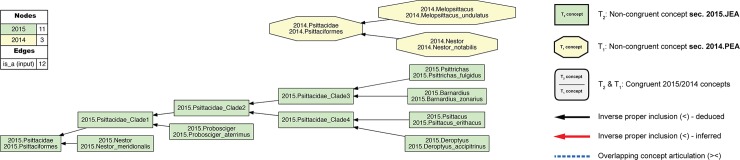
Alignment visualization for the 2015./2014.Psittaciformes alignment, with coverage globally applied.This alignment corresponds to the Fig 1 input, and shows reasoner-inferred non-/congruent concepts and articulations (see legend)–i.e., none in this particular case. The reasoner infers 108 logically implied articulations that constitute the set of MIR. See also S2 File. Although the input and alignment of Figs 1 and 2 are empirically defensible, they fail to capture certain intuitions we have regarding the higher-level 2015./2014.Psittaciformes relationship. For instance, we may wish to say: "Sure, the author teams sampled complementary species-level concepts. Yet these trees are not actually in conflict. At higher levels, there likely is agreement that parrots are parrots, and non-parrots are non-parrots". That is: 2015.Psittaciformes = = 2014.Psittaciformes. To obtain this intuitive alignment, we have to locally relax coverage at select lower levels (Fig 3). In particular, 2015.PEA include five genus- and species-level concepts under 2015.Psittacidae that have no corresponding region under 2014.Psittacidae. However, if we relax coverage for 2014.Psittacidae–i.e., we assert 2014.nc_Psittacidae as an input constraint–then we can include each of these; for instance: 2015.Probosciger_aterrimus < 2014.Psittacidae, 2015.Psittacus_erithacus < 2014.Psittacidae, etc. Conversely, if we locally relax coverage for 2015.Psittacidae (2015.nc_Psittacidae), we can specify 2014.Melopsittacus_undulatus < 2015.Psittacidae. At the genus level, we can align 2015.Nestor = = 2014.Nestor if we relax coverage for each (2015.nc_Nestor, 2014.nc_Nestor), in spite of the mutually exclusive species-level concepts sampled. Jointly, these four instances of relaxing coverage render the articulation 2015.Psittacidae = = 2014.Psittacidae consistent, and hence also 2015.Psittaciformes = = 2014.Psittaciformes (Fig 4).